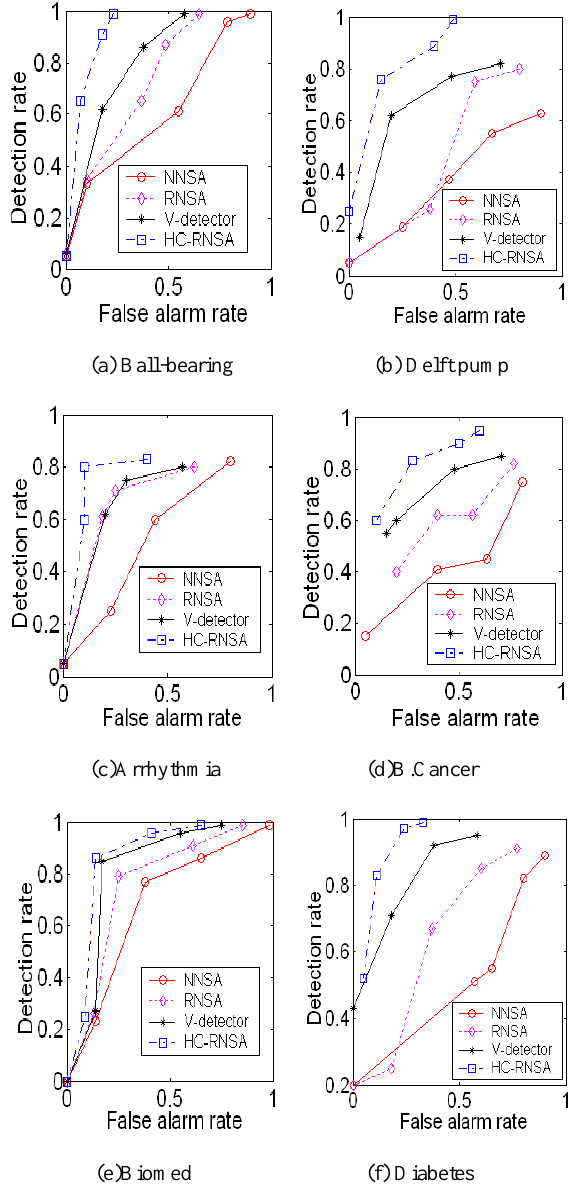
Fig. 4. The receiver operating characteristic